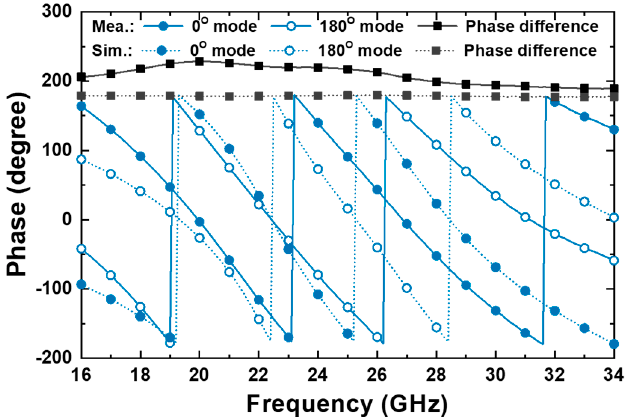
Figure 11. Simulation and measurement results: phases and phase difference of the 0°- and 180°- modes.